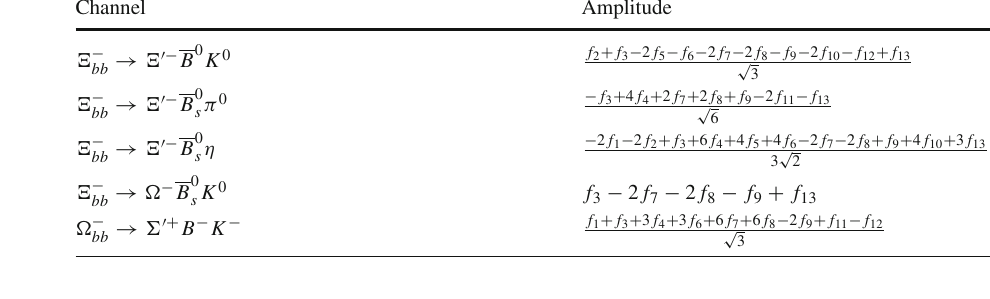
Table 35 Doubly bottom baryon decays into a bottom meson, a light baryon(10) induced by the charmless b → s transition and a light meson